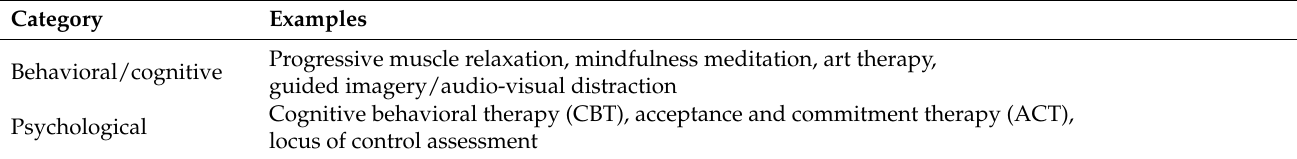
Table 7. Nonpharmacologic Interventions for Postoperative Analgesia and